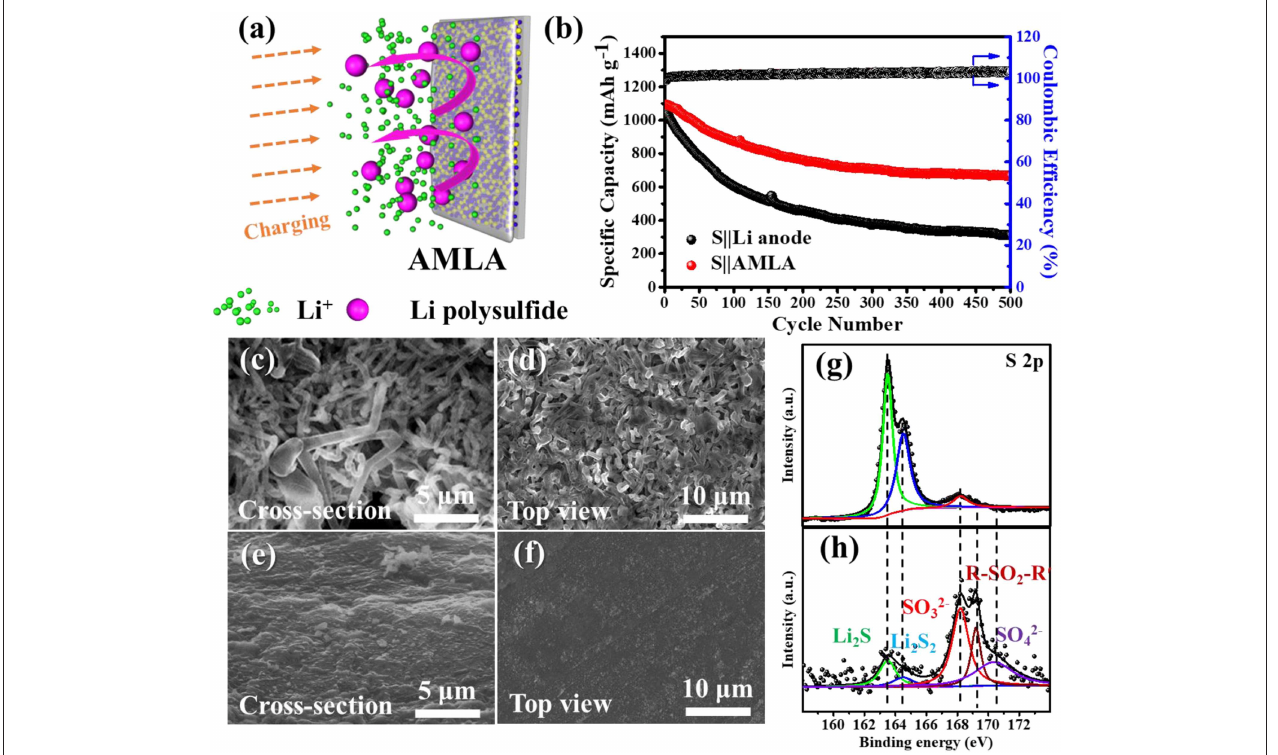
FIGURE 6 | The electrochemical performances of the Li-S cells. (a) The schematic of great effect of AMLA in the full cell. (b) The cycle performances of S||AMLA and S||Li anode cells under galvanostatic test with the current density 0.5C (1C = 1,675mA g − 1 ). (c,d) SEM images of cross-section and top-view of Li anode after cycles. (e,f) SEM images of cross-section and top-view of AMLA after cycles. The XPS spectra of S 2p elemental: AMLA (h) and Li anode (g) electrodes after